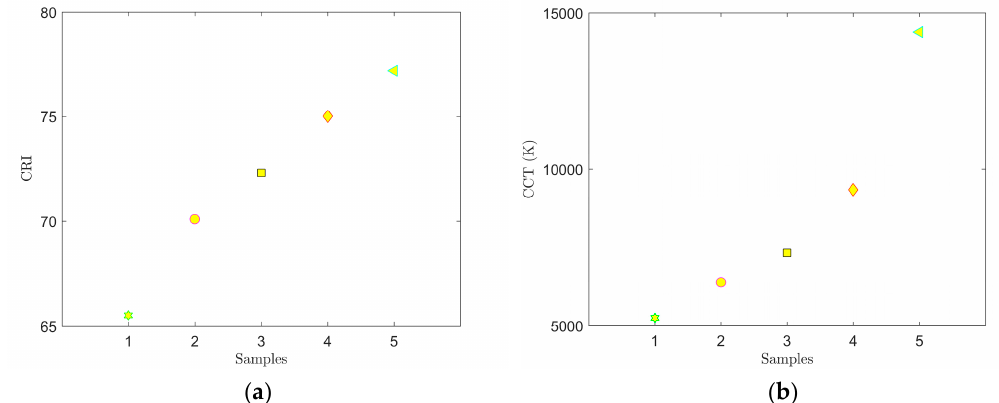
Figure 4. Location of samples 1–5 in the CIE 1931 color diagram ( a ), and spectra of samples 1–5 ( b ).